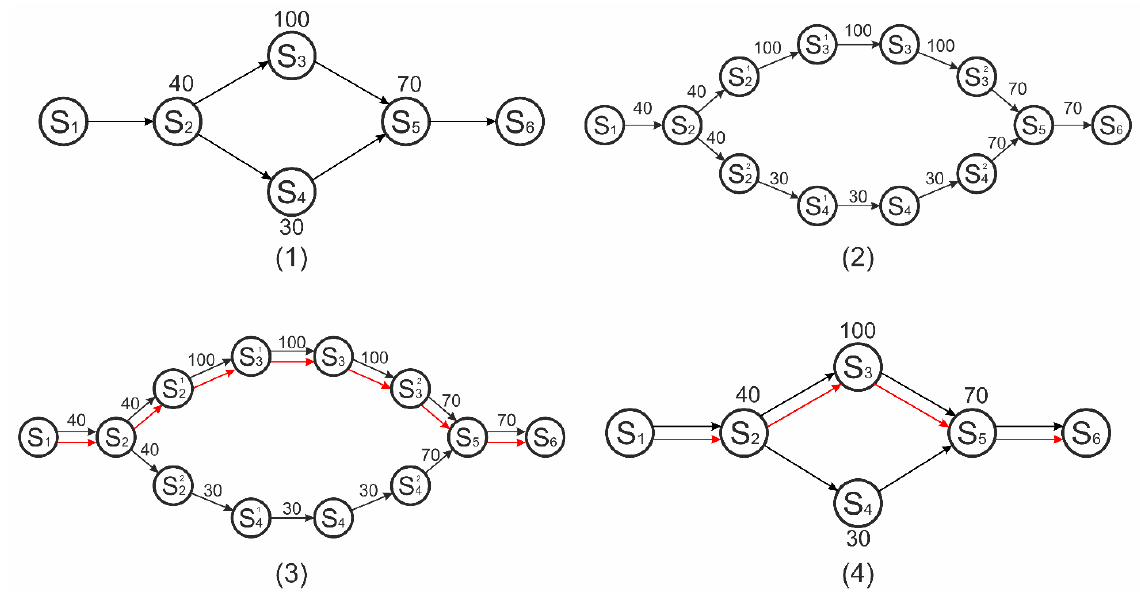
network. Schematically, this can be depicted as follows in Figure 4.